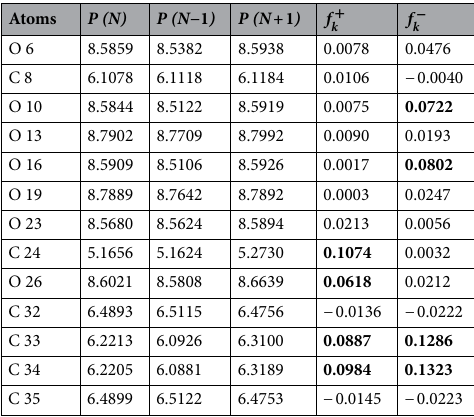
+ f − k , k for polysorbate 80 in aqueous